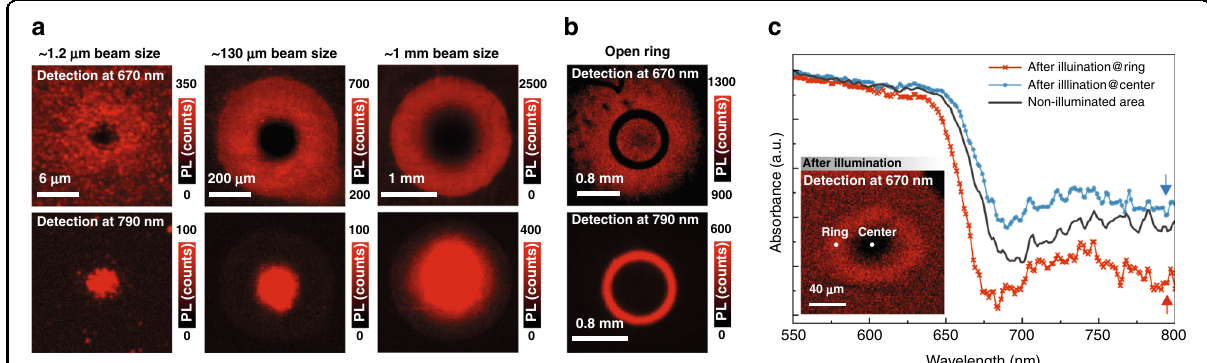
Fig. 3 The ion distribution with different pump beam sizes and shapes and the chemical composition analysis of the ring structure. a PL emission mapping at a detection wavelength of 670 and 790 nm after local illumination for 1 h at beam size of ~1.2 μ m/8 suns, ~130 μ m/1 sun, and ~1 mm/1 sun, respectively. b PL mapping after local illumination with a beam size of ~1 mm over an annular aperture with a 1 mm diameter pinhole and a center obstruction target of 850 μ m. c Absorption spectra of the fi lm at the brightest position of the ring and the center of the illuminated region with a reference included. Inset shows PL mapping at 670 nm after local light illumination by ~12 μ m beam for 1